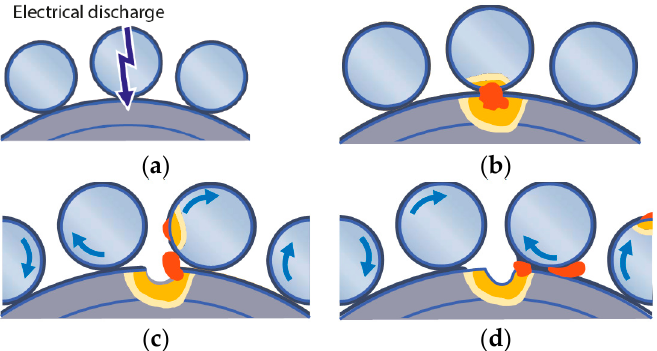
Figure 1. Electrical erosion produced on the bearing surfaces by means of the current leakage phenomenon that consist of: ( a ) the crossing of the electric current through the rolling elements; ( b ) the electric arc welding occurs between the rolling elements and bearing surfaces; ( c ) the molten material solidifies and then separates; ( d ) the excessive material in the rolling elements wears away.